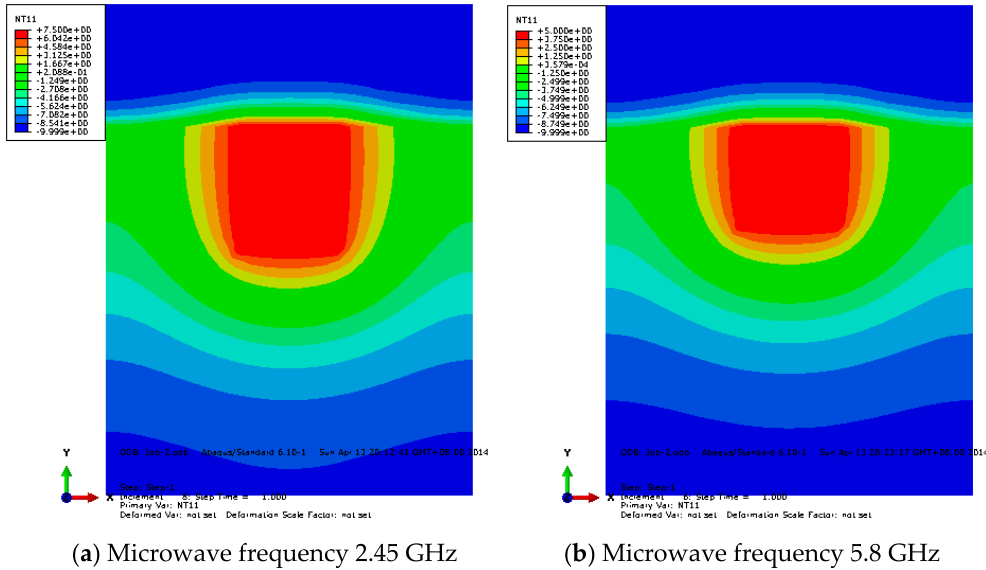
Figure 5. Distribution of the temperature field at different microwave frequencies.